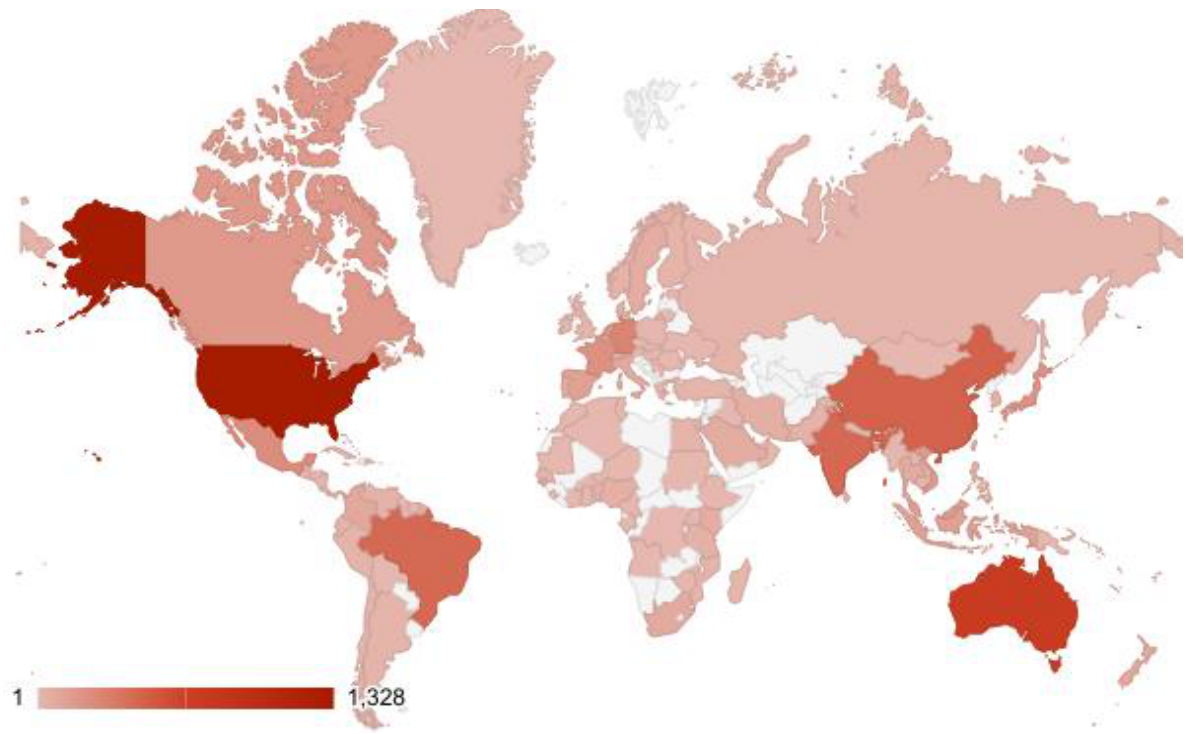
Figure 3. The total number of research publications on the impact of climate change on mangroves per country on mangrove forest-related studies. The darker orange reflects the greater number of manuscripts, while lighter shades reflect a moderate number to fewer publications.